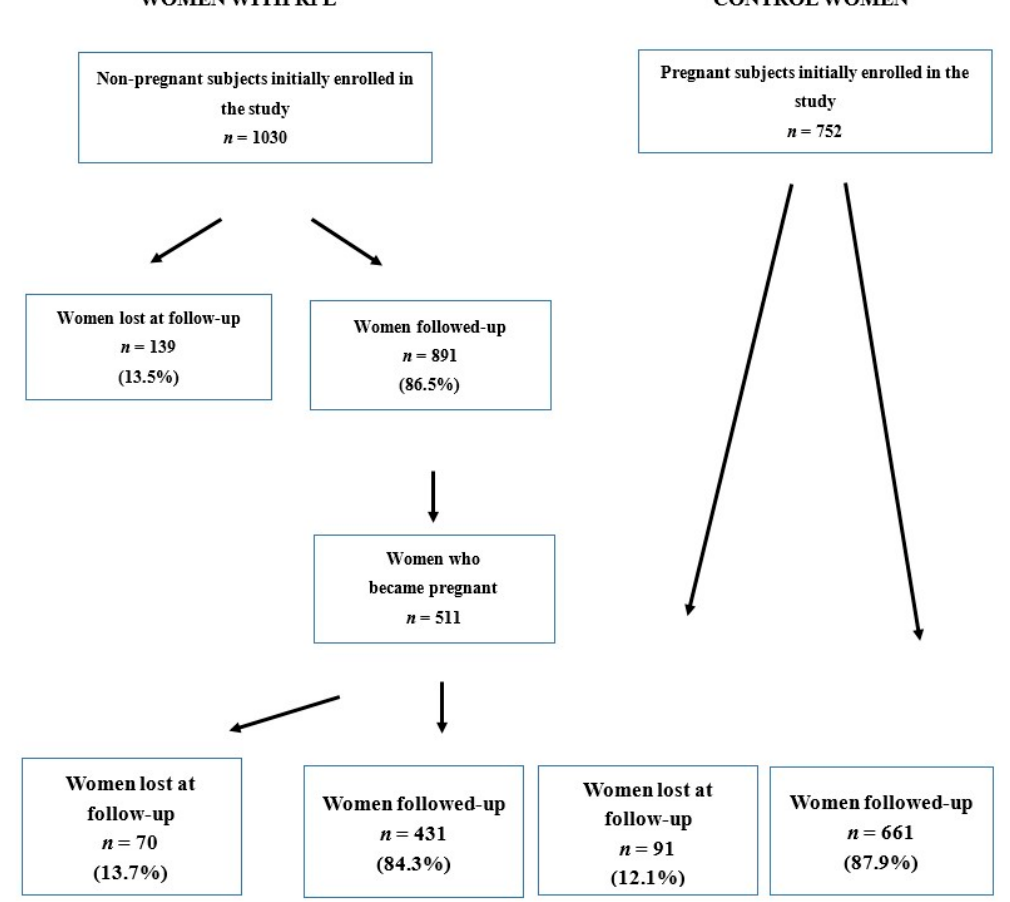
Figure 1. Distribution of the subjects enrolled in the study according to the follow-up.